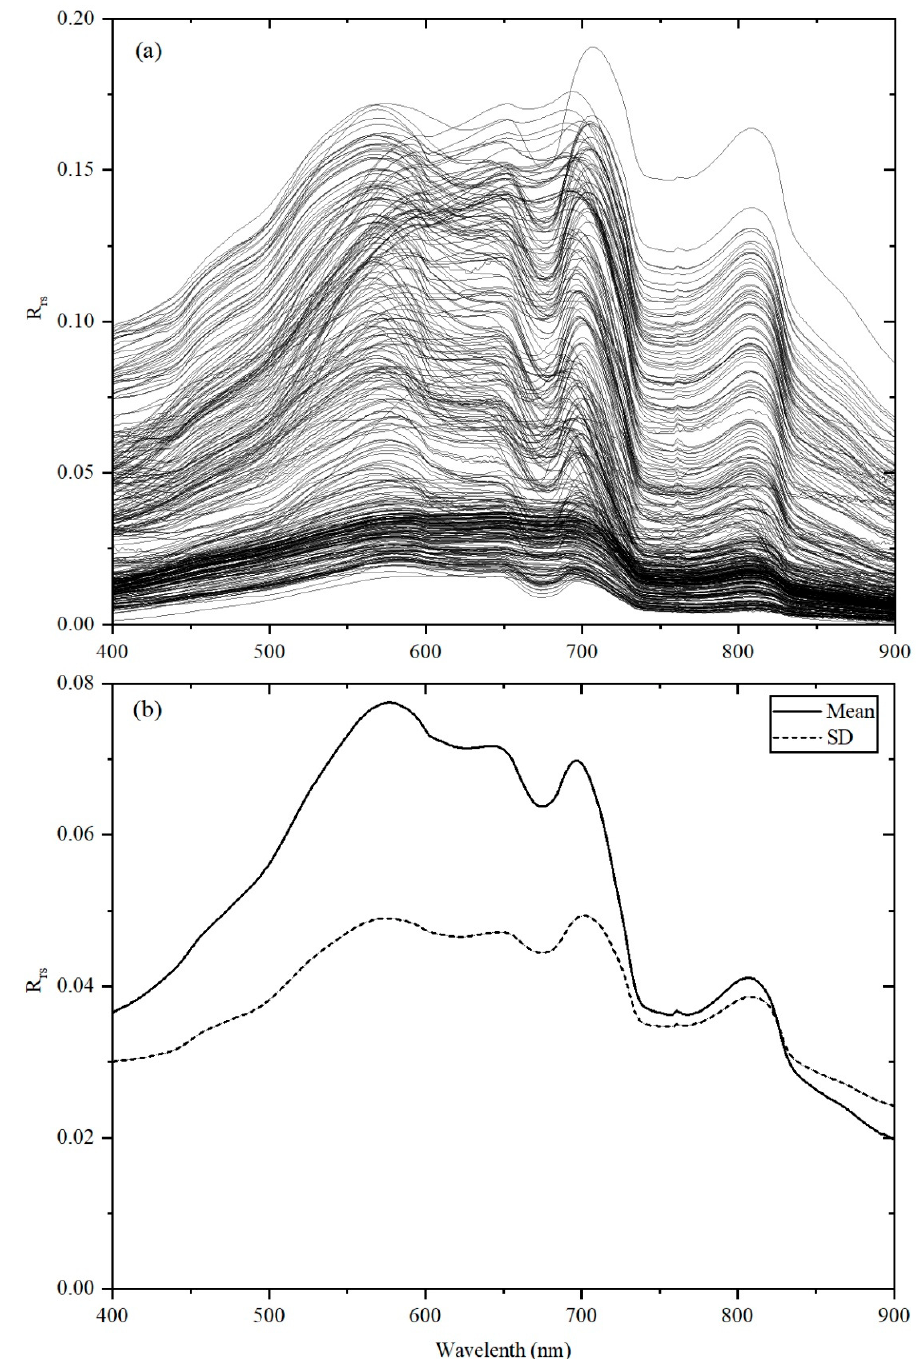
Figure 3. ( a ) In situ spectra. ( b ) Mean and standard deviation (SD) of the in situ spectra.